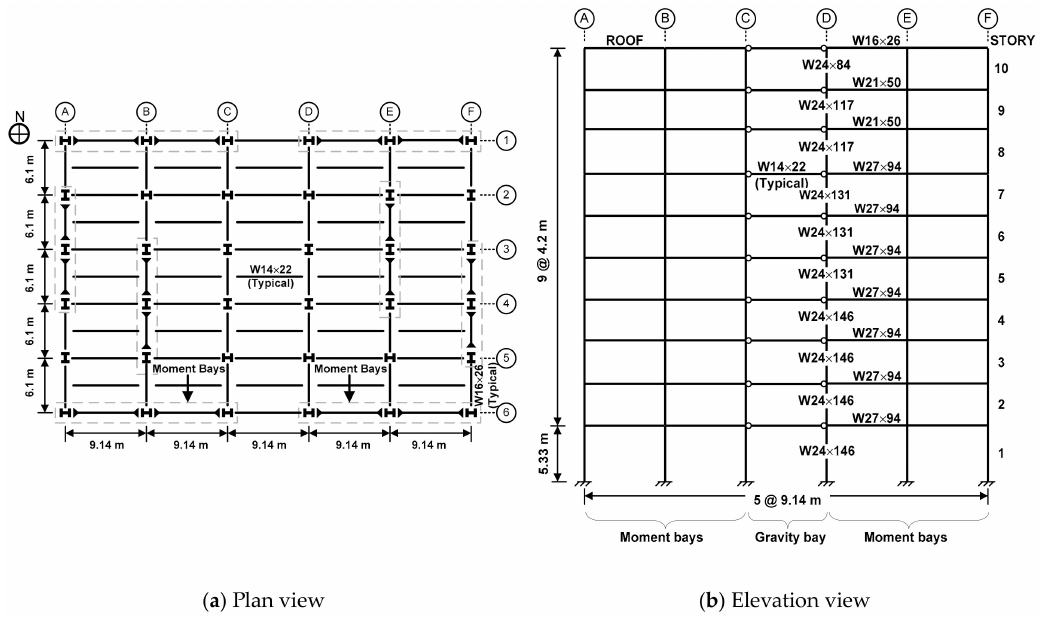
Figure 23. Prototype